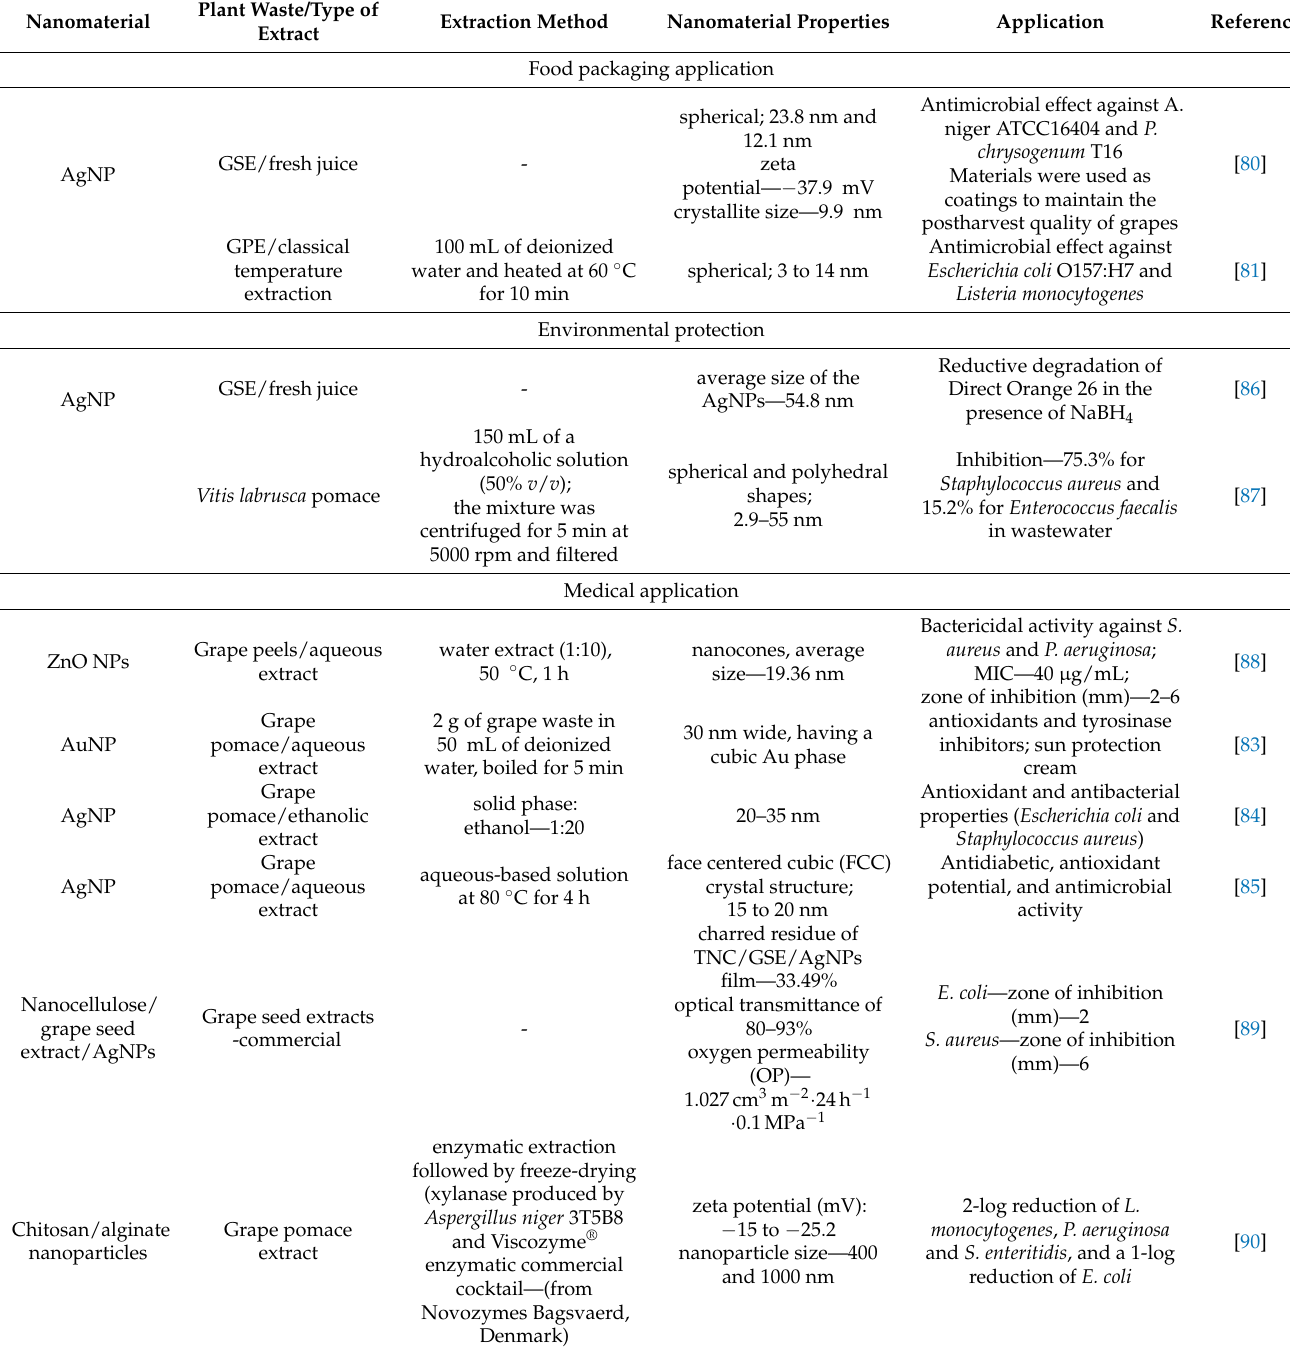
Table 2. Different applications of materials obtained using green methods